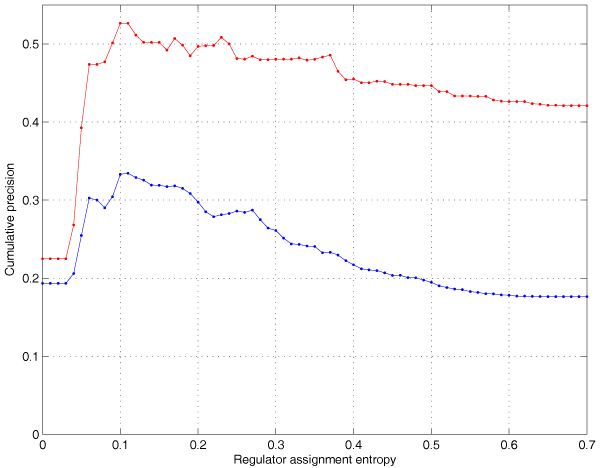
Cumulative distribution of precision as a function of regulator entropy. Cumulative distribution of precision as a function of regulator entropy for the data set with 100 experiments and 150 modules: each point at an entropy value x (spaced at 0.01 intervals) gives the precision of all (blue) or top (red) regulators with assignment entropy ≤x.